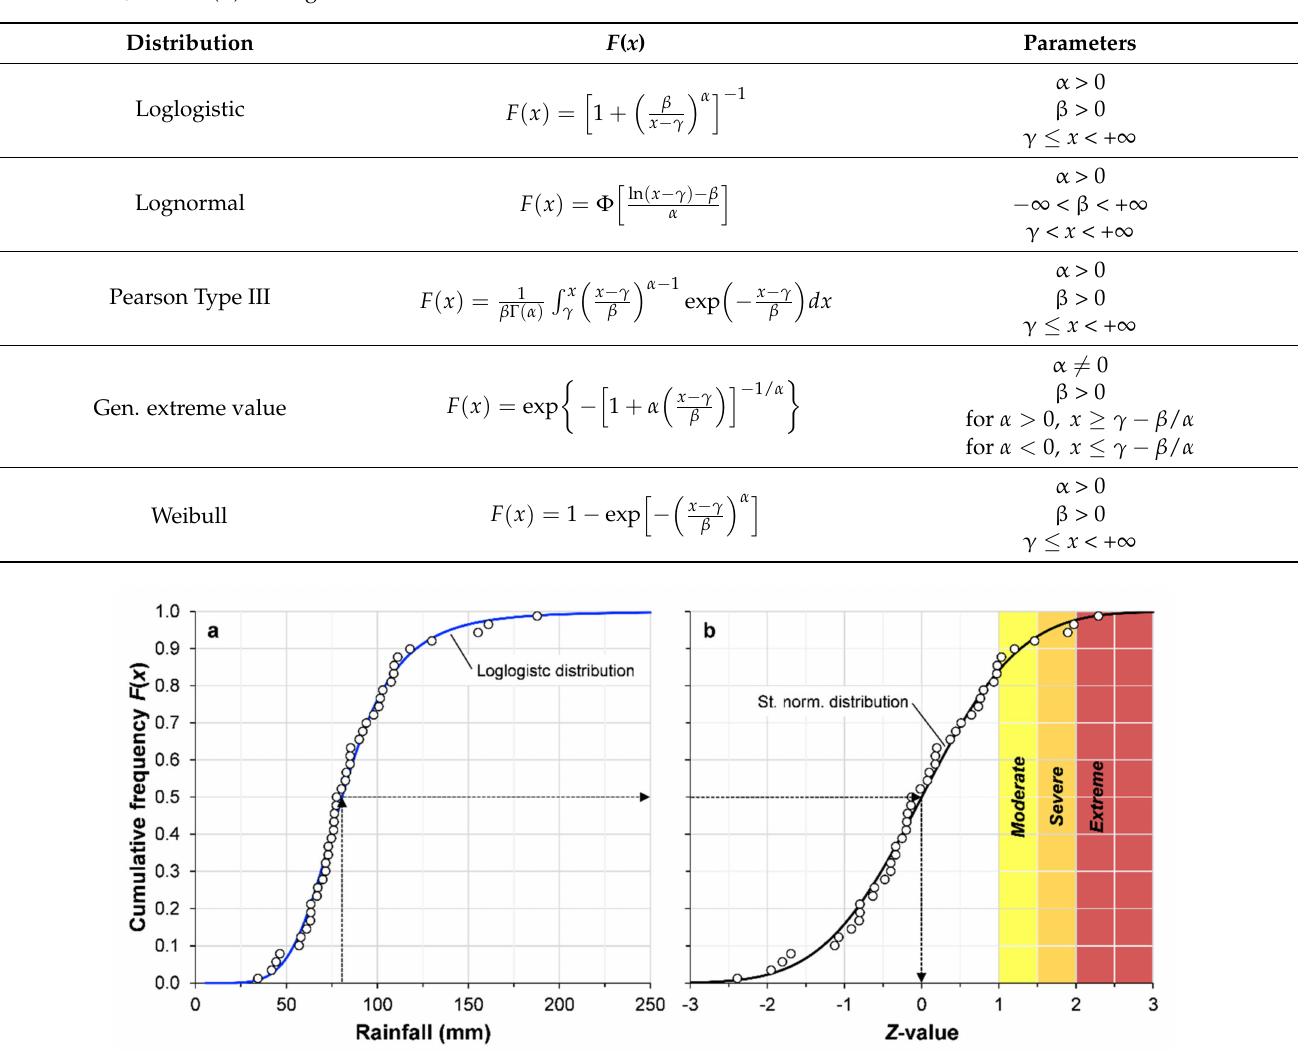
Table 2. Cumulative distribution functions F ( x ) and their parameters; Φ is the standard normal cumulative distribution function, while Γ ( α ) is the gamma function.